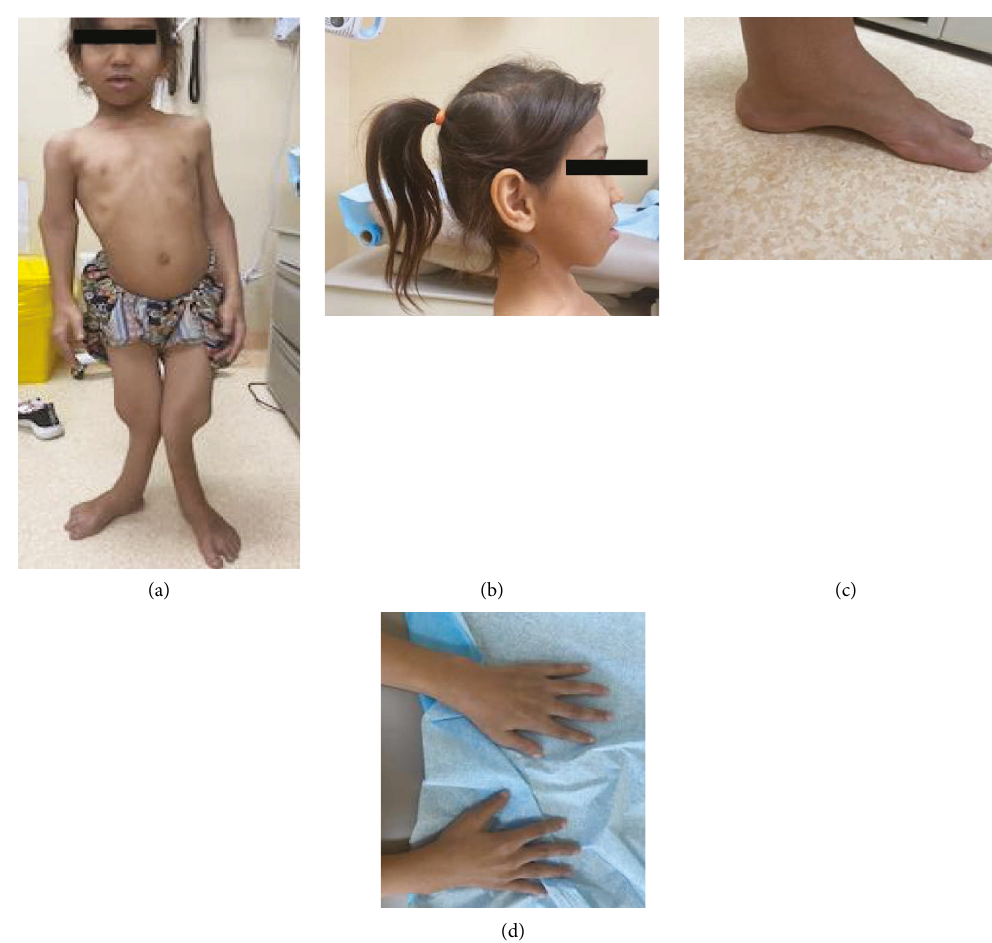
Figure 1: Clinical pictures. (A, B) Triangular face with prominent cheekbones, retromicrognathia, protruding external ears, short neck, pectus carinatum, protruding abdomen, shortening of limbs, and knock knee. (C, D) Pes cavus foot and